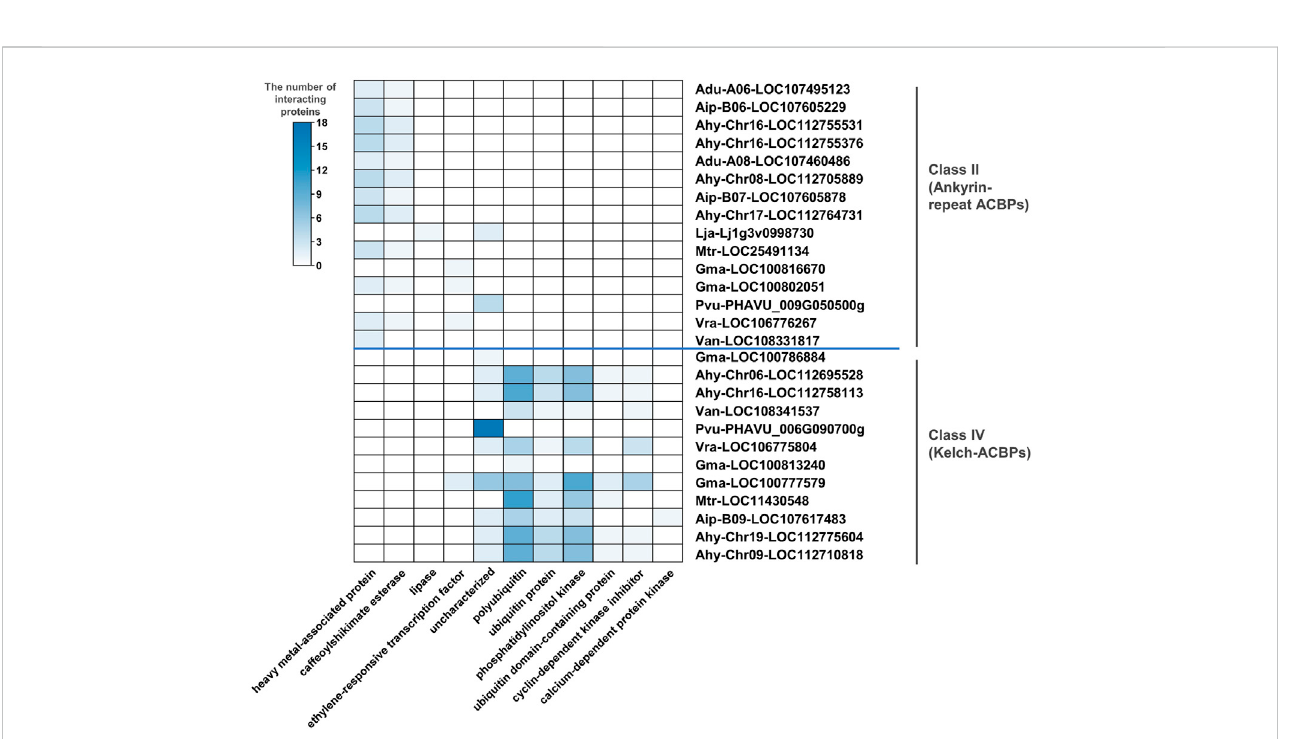
FIGURE 5 The protein types interacting with legume ACBPs. The heat map was generated from the number of different proteins interacting with legume ACBPs. The color scale bar ranging from white to blue represents an increase in the number of interacting proteins. No interacting proteins predicted for ACBPs of class I and class